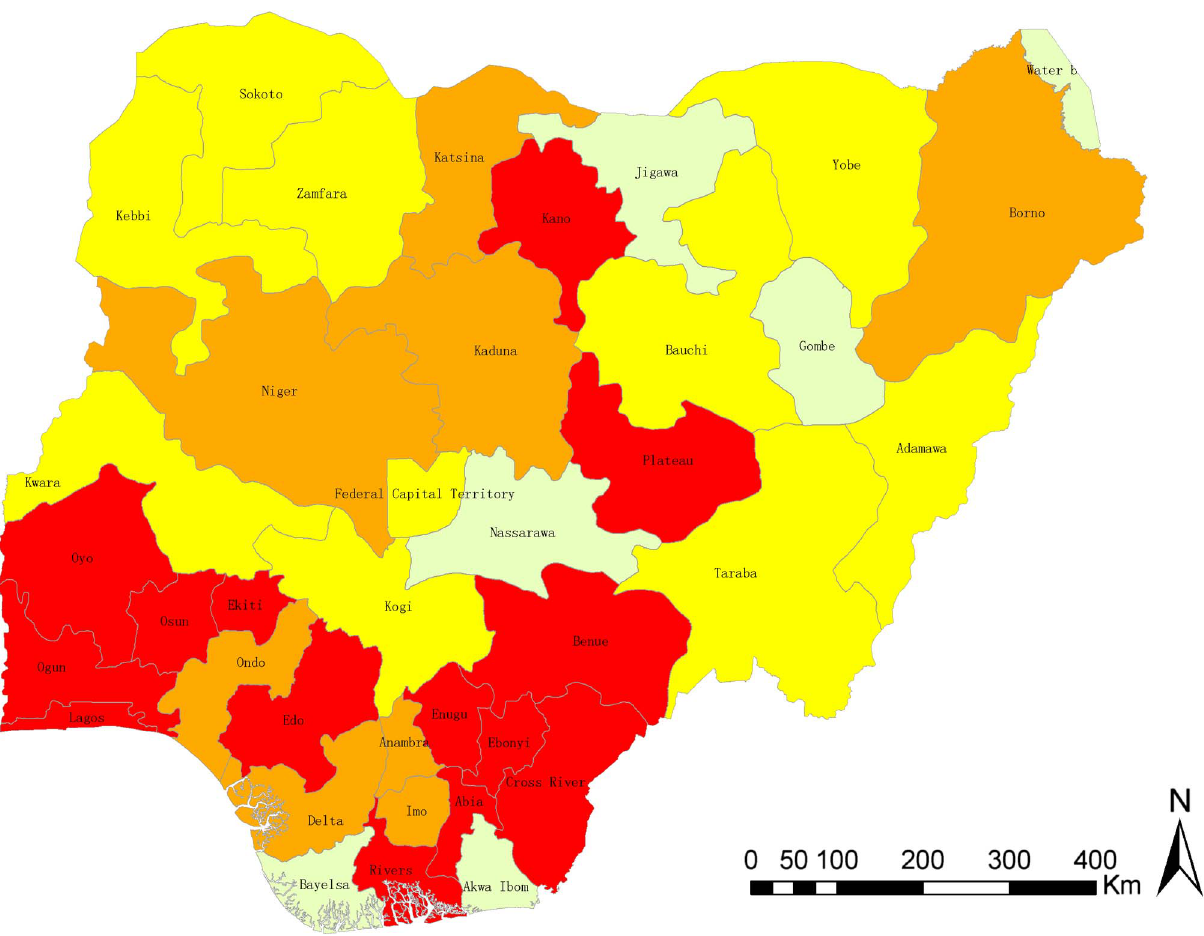
Figure 4. Map of Nigeria, showing the level of endemicity of urinary schistosomiasis by state. Red: highly endemic (>50%); brown: moderately endemic (10 – 50%); yellow: low endemic (1 – 10%); grey: no report of urinary